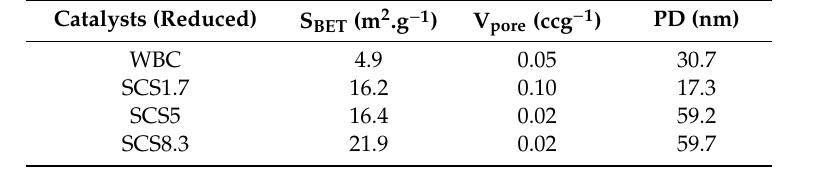
Table 3. The N 2 physical adsorption results of the catalysts prepared by SCS and WBC catalyst.